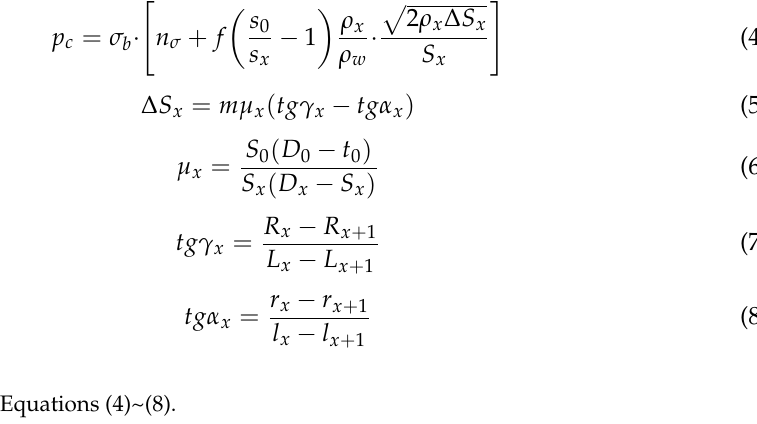
Figure 5. The curves of normal pressure per unit area in wall-reduction zone with different feed rate.